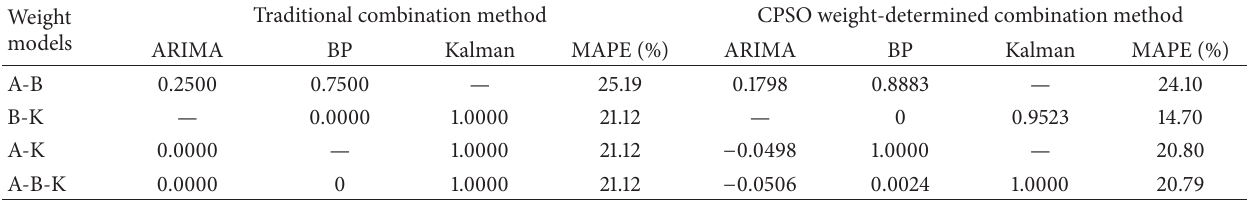
Table 7: Weights of the individual models in the combination models.